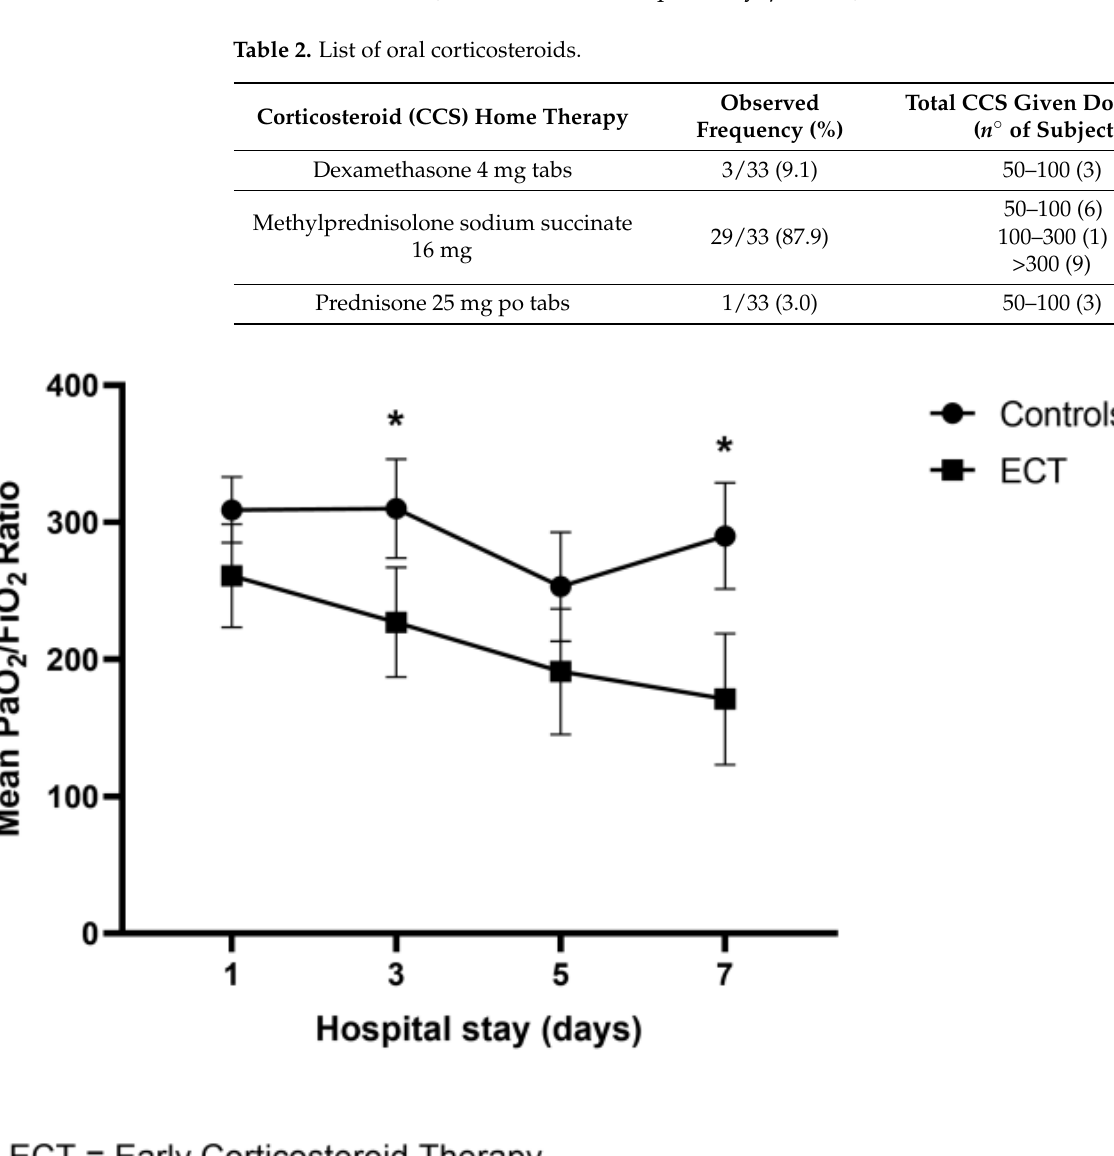
Table 2. List of oral corticosteroids.